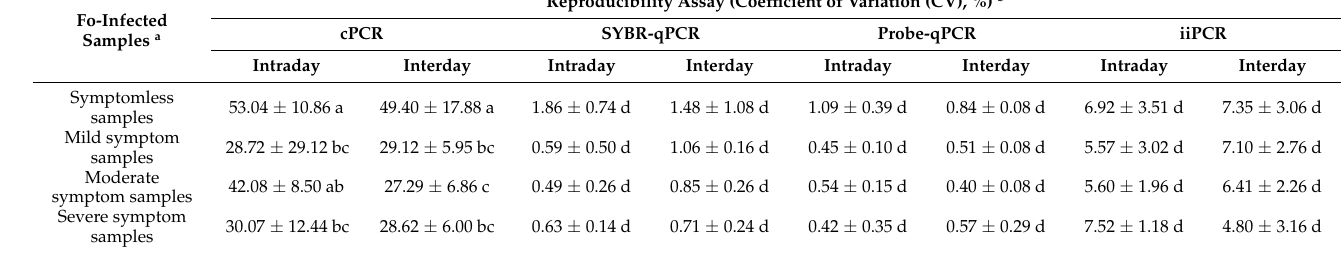
Table 7. Reproducibility evaluation of molecular detection assays using as testers various Fusarium oxysporum -infected asymptomatic and symptomatic banana pseudostem samples extracted by rapid DNA extraction.